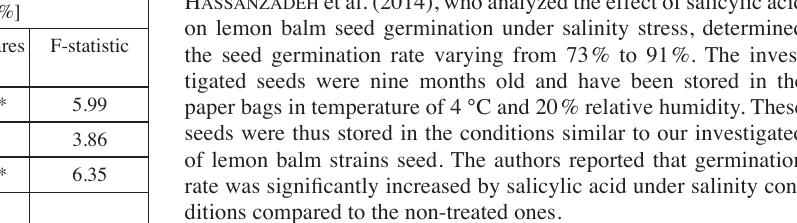
Tab. 5: Mean squares of two-way analysis of variance for germination rate done in peat medium Source of variation